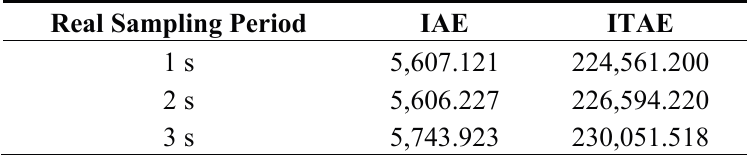
Table 4. Comparison of performance indexes of the WNCS for different sampling periods of the wireless sensor: soft sensor with multi-rate of 0.1 s.